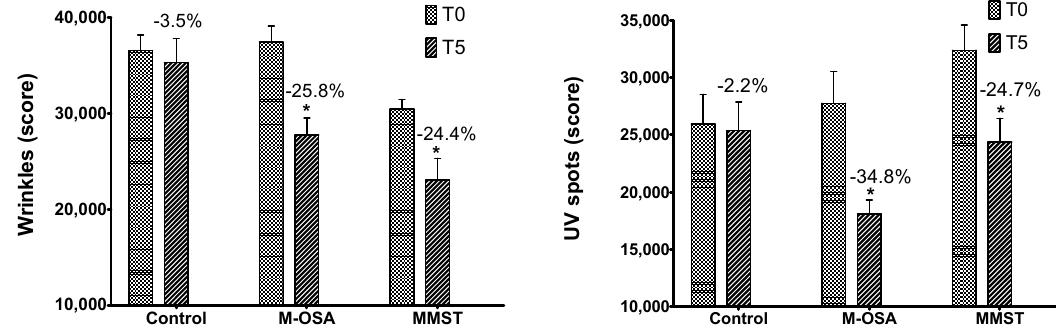
Figure 1. Skin multispectral imaging data for parameters that showed significative results. * Statistically significant difference from T0. G1 = control (placebo). G2 = maltodextrin-stabilized orthosilic acid. G3 = monomethylsilanetriol. T0 = baseline. T5 = 5 months of study.